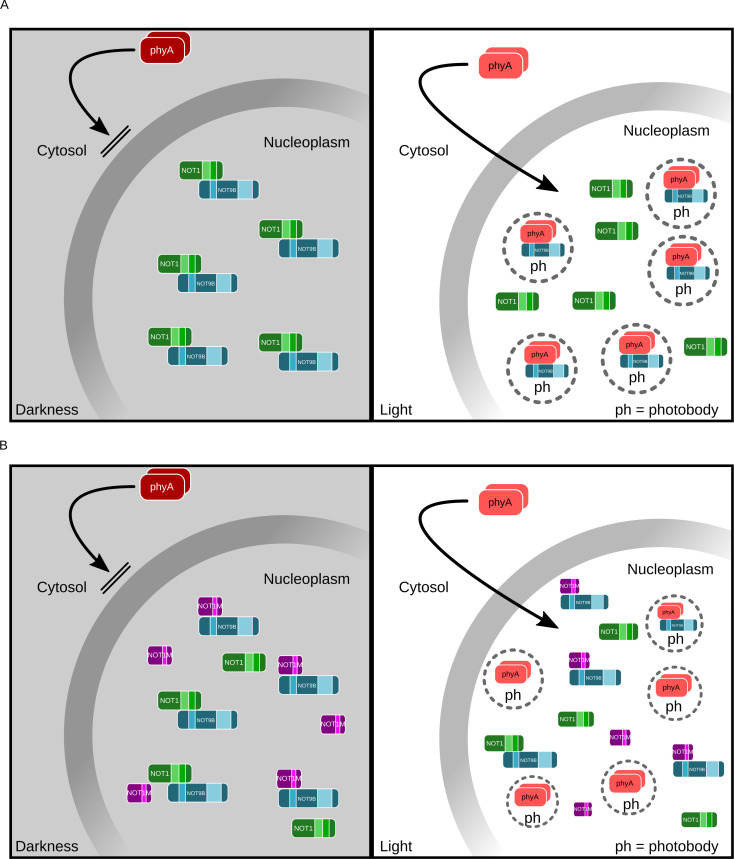
Model for NOT9B photobody formation in wildtype and NOT1 Mox background.(A) Light-activated phyA translocates from the cytosol into the nucleus and recruits NOT9B into photobodies through binding to the PNB site. (B) Partially blocking the PNB site of NOT9B by overexpression of NOT1 M is therefore expected to reduce the number of NOT9B photobodies, while phyA photobodies should not be affected.